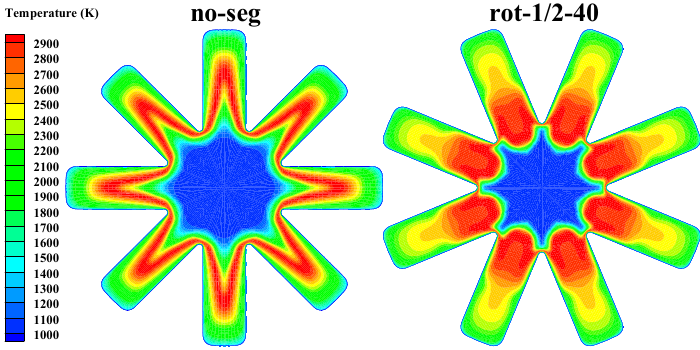
Figure 18. Temperature comparison of the cross sections at the front end of aft-section grain port.